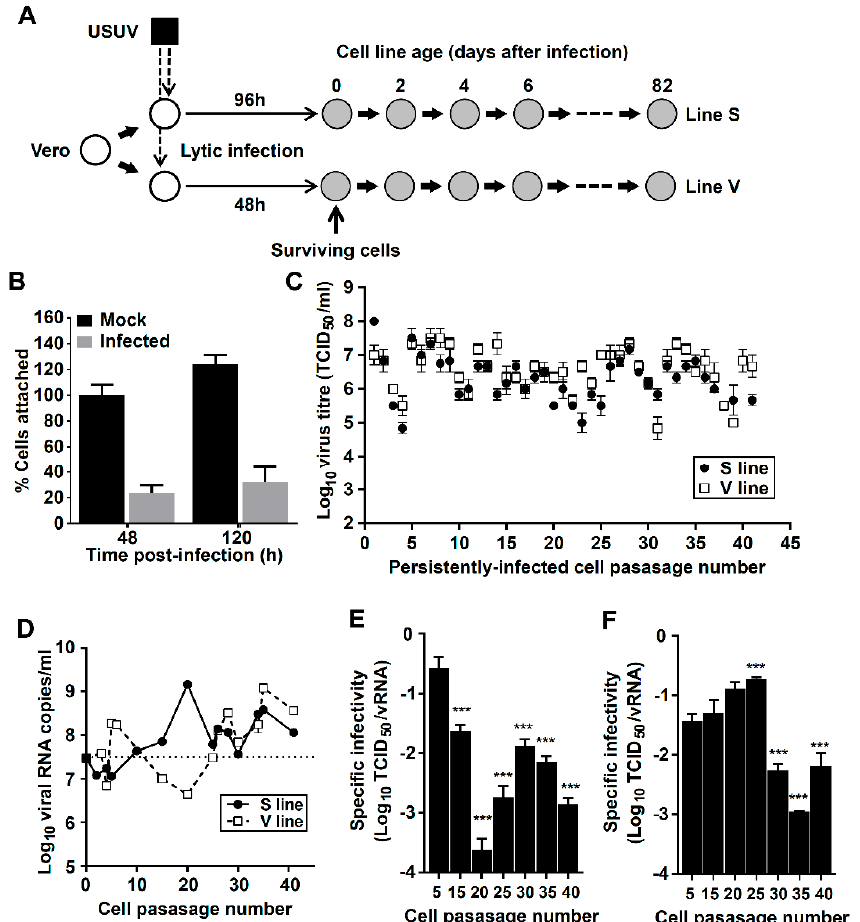
Figure 1. Establishment of cell culture systems of persistent Usutu virus (USUV) infection. ( A ) Schematic representation of the procedure followed to the establishment and maintenance of Vero cells persistently infected with USUV. Uninfected cells are represented as white circles, persistently-infected cells as grey circles, and cell passages with thick arrows. Vero cell monolayers are infected with USUV (black square) at an MOI of 0.01. At 48 (V cells) or 96 h (S cells), unattached dead cells are removed and the surviving cells cultured in fresh media. Cells are passaged every 48 h using standard procedures. ( B ) Percentage of cells that remain attached to a 16-mm dish at 48 or 120 h after USUV (grey) or mock infection (black). These values are relative of mock-infected cells at 48 h post-infection. ( C ) USUV titers in persistently-infected cells along passages. Viral titers in S cells supernatants are represented as black circles, V cells as white squares. ( D ) Viral RNA in cell supernatants of V (white squares) and S cells (black circles) along passages. The number of molecules in each passage was determined by qPCR using primers targeting the Env-coding region. ( E ) and ( F ), USUV specific infectivity in the supernatant of V ( E ) and S cells ( F ). Specific infectivity is determined as the ratio between infectious units (TCID 50 ) and the number of viral genome equivalents detected in the samples. Statistically significant differences are represented by asterisks (*** p < 0.001). Two-way ANOVA test.